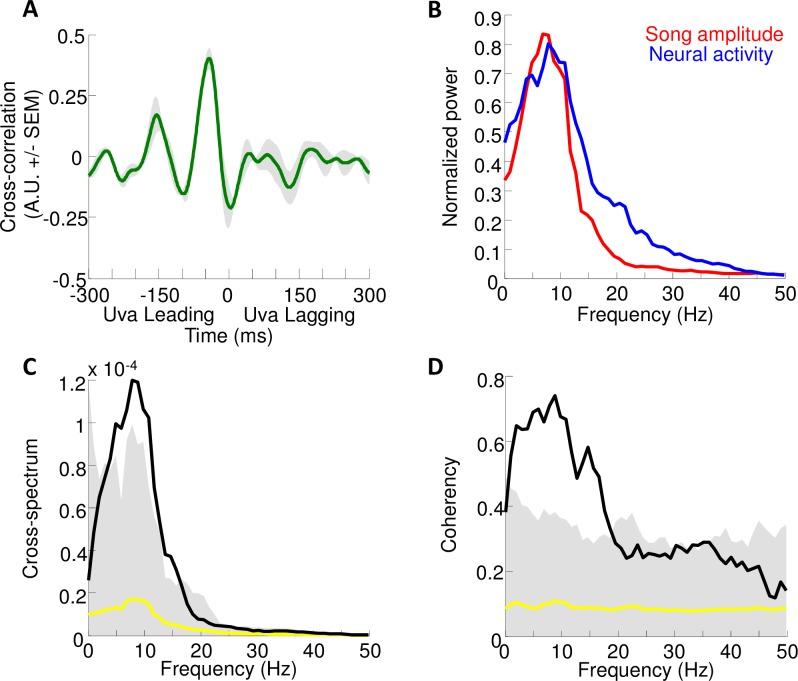
Quantification of rhythmic activity in Uva.(A) Cross‐correlation function between Uva activity and sound amplitude averaged across 5 birds (green: mean cross-correlation, shaded region: SEM; peak correlation = 0.40±0.04, mean lag at peak correlation = 42±6ms). (B) normalized power spectra of the song amplitudes (red) and Uva multiunit activity (blue), averaged across n = 5 birds. A broad peak in the power spectrum is seen in both the song amplitude and neural data, centered ~10Hz. (C) Cross-spectrum between Uva activity and sound amplitude averaged across n = 5 birds (black: mean, yellow: null cross-spectrum, shaded region: 95% percentile corrected for multiple testing) (D) Coherency between Uva activity and sound amplitude averaged across n = 5 birds (black: mean, yellow: null cross-spectrum, shaded region: 95% percentile corrected for multiple testing). Note a large, significant peak is observed in both the cross-spectrum and the coherence at ~10Hz (Fpeak = 8.8Hz, Cpeak = 0.75, p<0.01, phase = -0.77π).